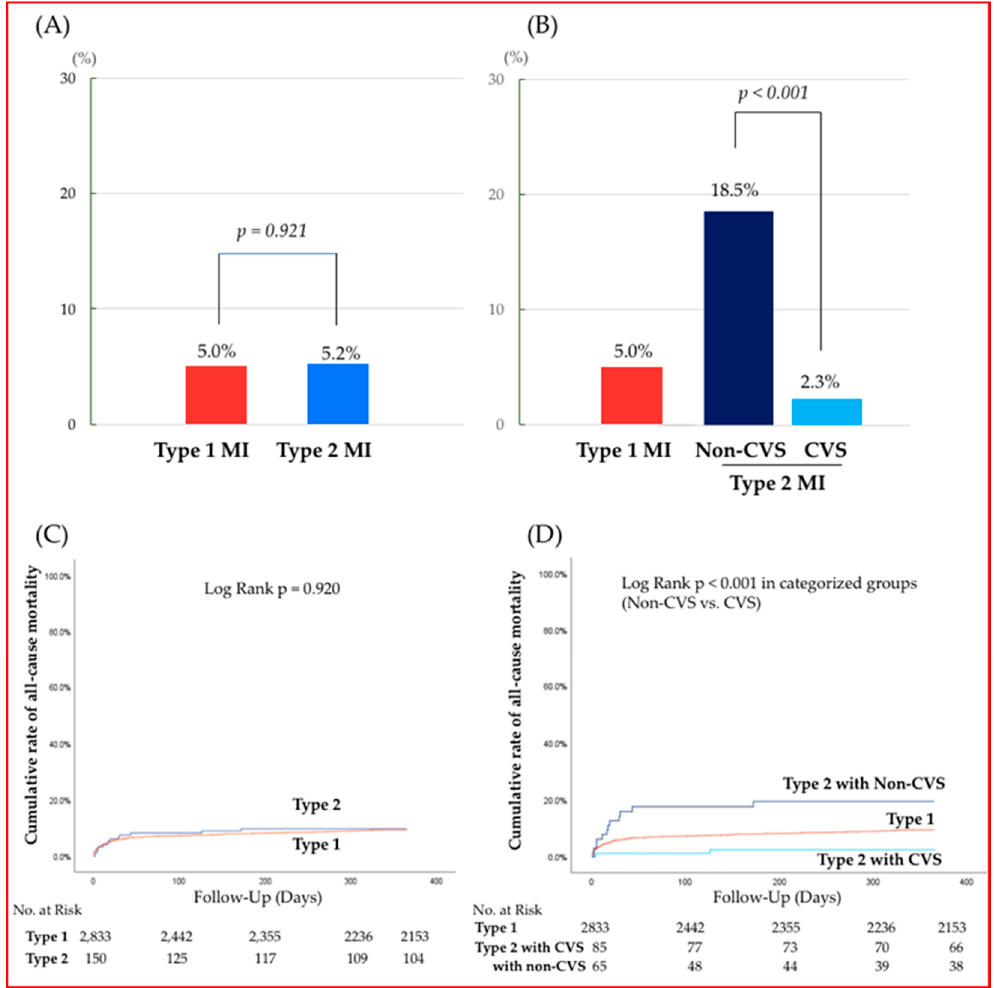
Figure 3. Event rates and Kaplan–Meier estimates of all-cause mortality at 1year period. (Upper) All-cause mortality between Type 1 MI and Type 2 MI ( A ) and the mortality among the 3 groups, when Type 2 MI is stratified into 2 groups ( B ) within 1-year period. (Lower) Kaplan–Meier estimates of all-cause mortality between Type 1 MI and Type 2 MI ( C ) and the mortality among the three groups, when Type 2 MI is stratified into two groups ( D ) within 1-year period.